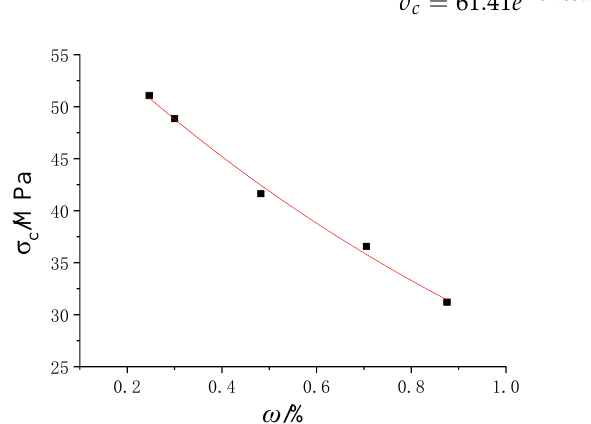
Figure 9. The relationship between the triaxial compressive strength and the rock water content. The relationship between the elastic modulus and the water content is displayed in Figure 10, which points out that the average elastic modulus of the rock declined with the increasing immersion time. After immersion in water for 1 day, the elastic modulus with the rock water content of 0.2467% was 7.73 GPa, which was 5.73% lower than that in the natural state. After immersion in water for 7 days, the elastic modulus with the rock water content of 0.3001% was 6.20 GPa, which was 12.20% lower than that in the natural state. After immersion in water for 15 days, the elastic modulus with the rock water content of 0.4824% was 4.85 GPa, which was 40.85% lower than that in the natural state. After immersion in water for 30 days, the elastic modulus with the rock water content of 0.8755% was 4.00 GPa, which was 51.22% lower than that in the natural state. In the initial stage of the water immersion, the elastic modulus of the gypsum rock declined significantly, but gradually slowed down in the later stage. The results showed that the weakening effect of water on the deformation property of gypsum rock is very significant, especially in the initial stage of water immersion. It was found that the relationship between the elastic modulus and the water immersion time was approximately exponential. The Equation (12) below has been adopted to fit the data and the correlation coefficient is R 2 = 0.99972.